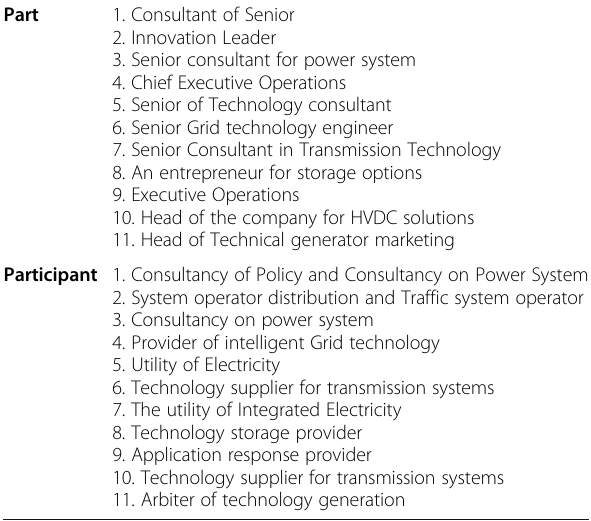
Table 1 An overview of interviews by experts